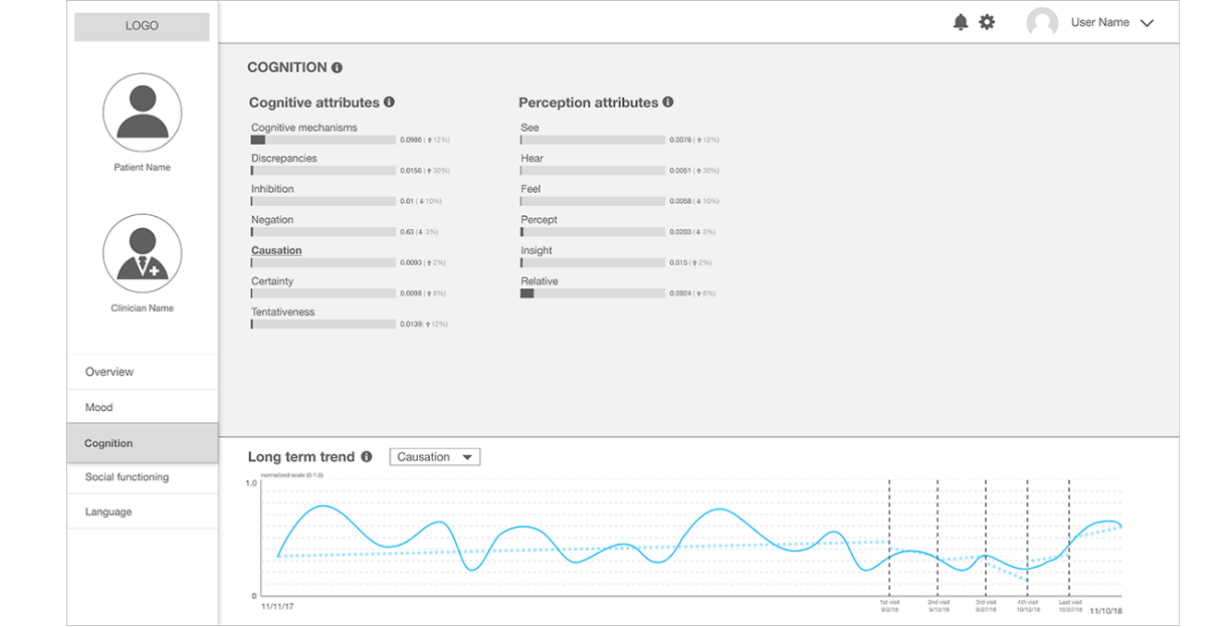
Figure 4. The second prototype: a clinical state and trend visualization interface –